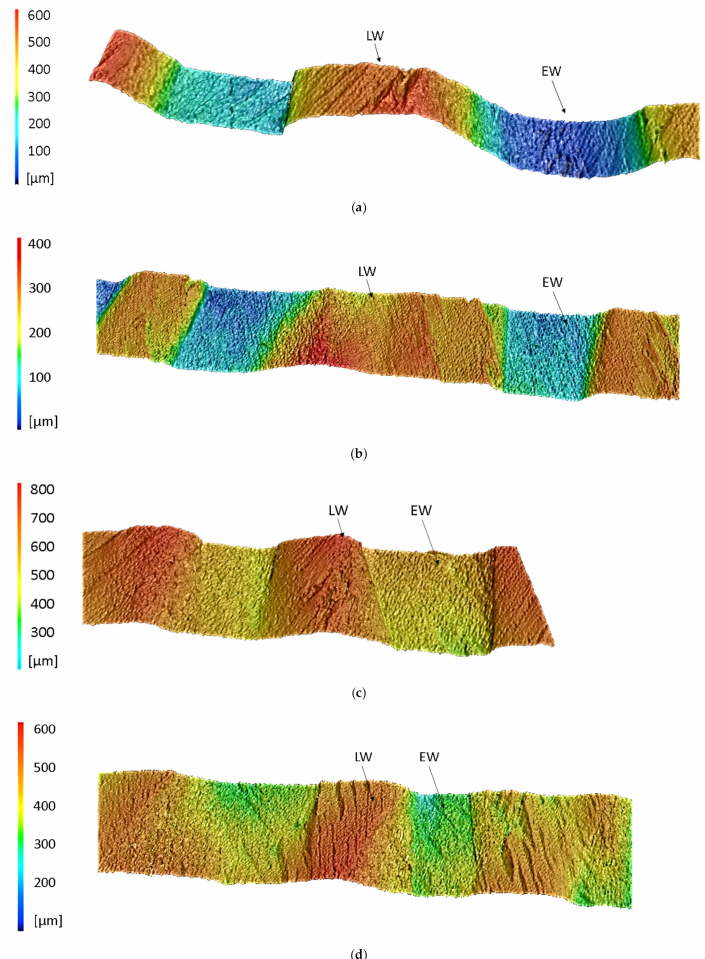
Figure 16. Sections of surface profiles of wood particles that were compacted with 10 MPa with an angular difference in the longitudinal direction of 0 ◦ ( a ), 5 ◦ ( b ), 10 ◦ ( c ) and 15 ◦ ( d ) for 10 min. at 23 ◦ C.